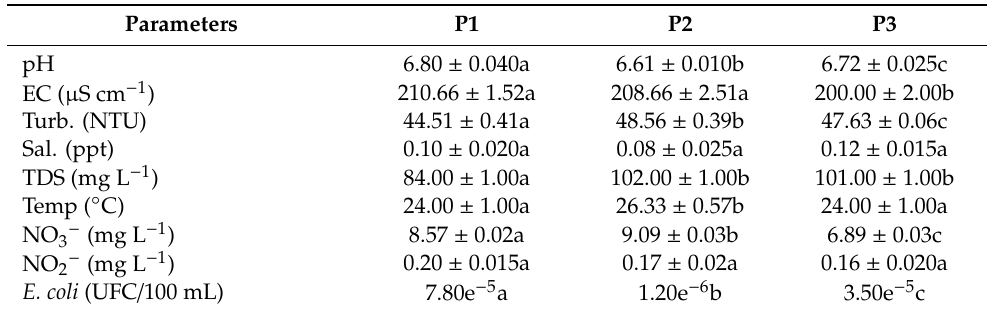
Table 2. Evaluation of the physicochemical and microbiological parameters in the three sampling points analyzed in the rainy